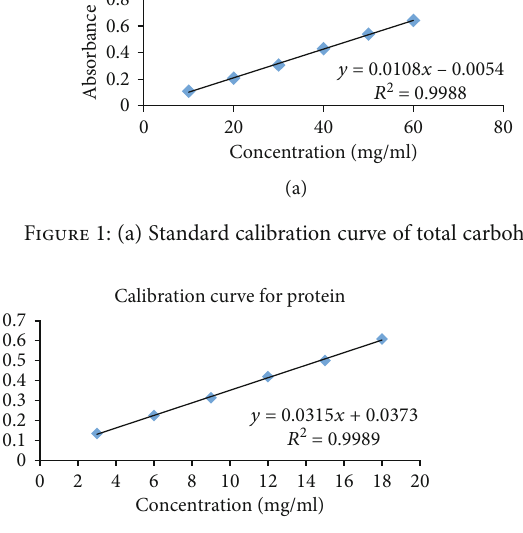
Figure 2: Standard calibration curve of protein.